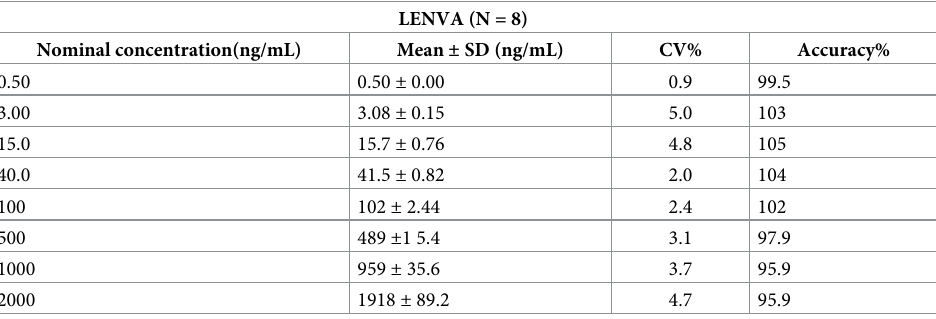
Table 4. Precision (CV%) and accuracy %data of LENVA calibration curves in human plasma.